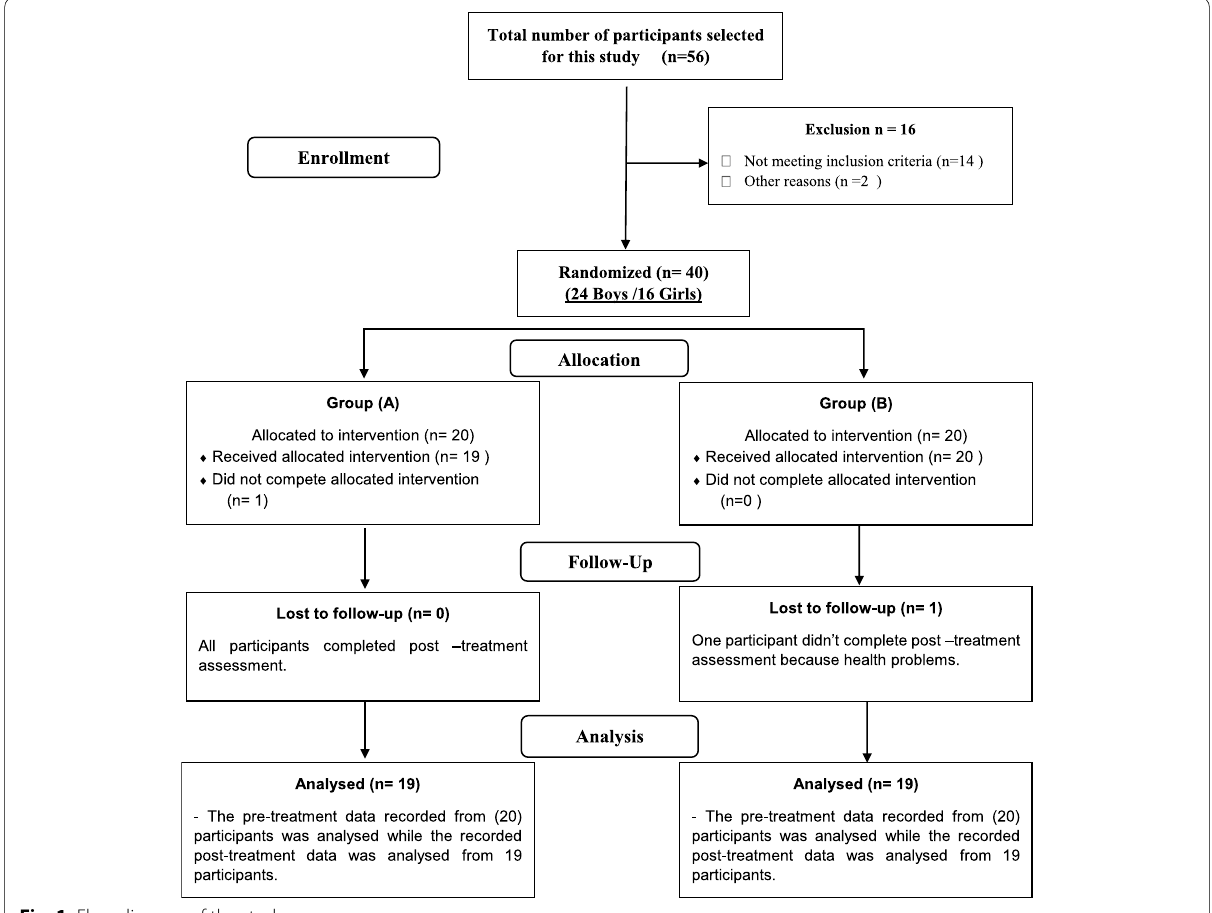
Fig. 1 Flow diagram of the